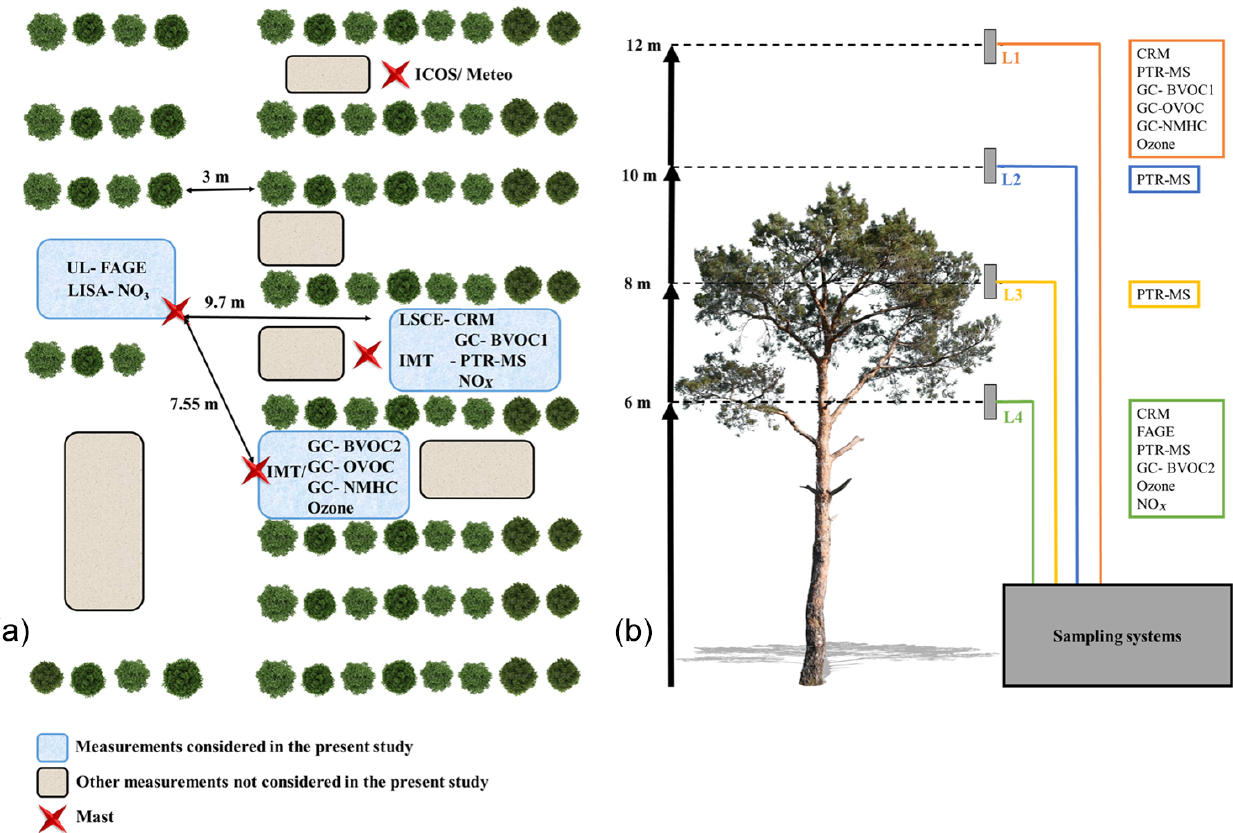
Figure 1. Deployment of instruments at the measurement site. (a) The horizontal deployment and (b) the different sampling levels with respect to the average tree